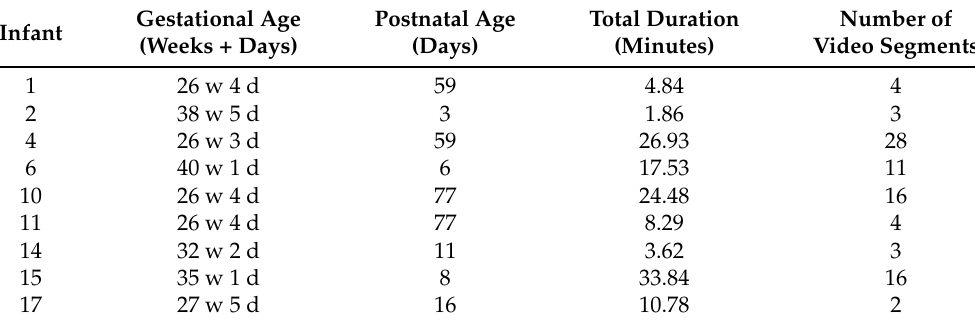
Figure 2. Percentages of video segments in which the infants are still with a minimum duration of 30 s, with flow visible, and with no periodic breathing. All percentages are reported with respect to the total recording time of 42 h. Table 1. Information on the infants and the data used in this